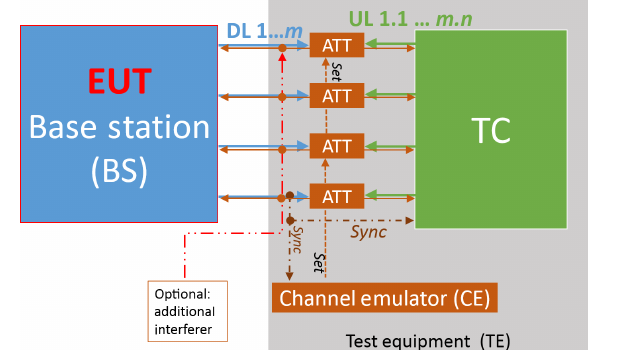
Figure 12. Test setup for BS testing.